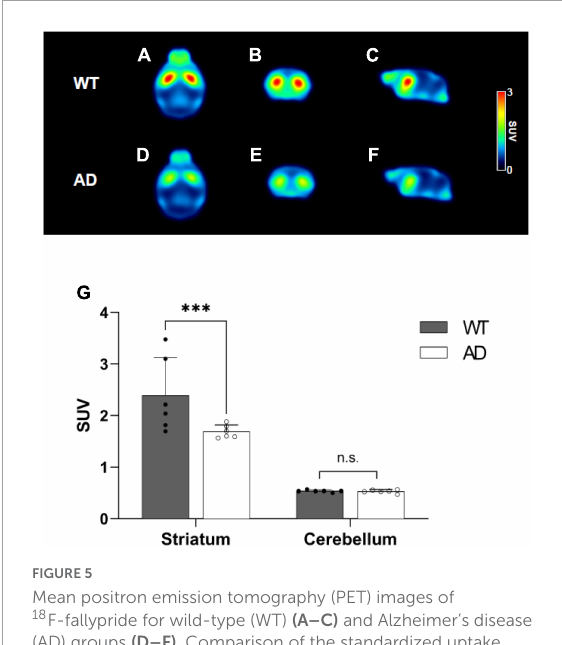
FIGURE5 Mean positron emission tomography (PET) images of 18 F-fallypride for wild-type (WT) (A–C) and Alzheimer’s disease (AD) groups (D–F) . Comparison of the standardized uptake values (SUVs) for the striatum and cerebellum for 18 F-fallypride at 30–50 min (G) . Data are presented as the mean ± SD ( n = 6). Statistical significance was defined as a p value less than 0.05 for comparisons between groups (**** p < 0.0001).